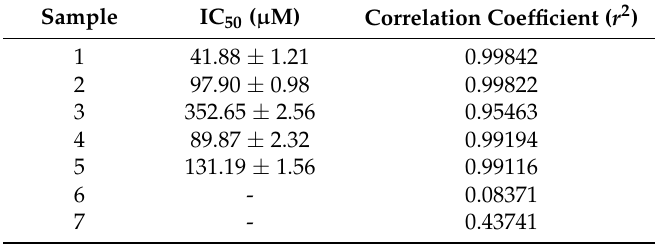
Table 8. DPPH radical scavenging activity of the isolated